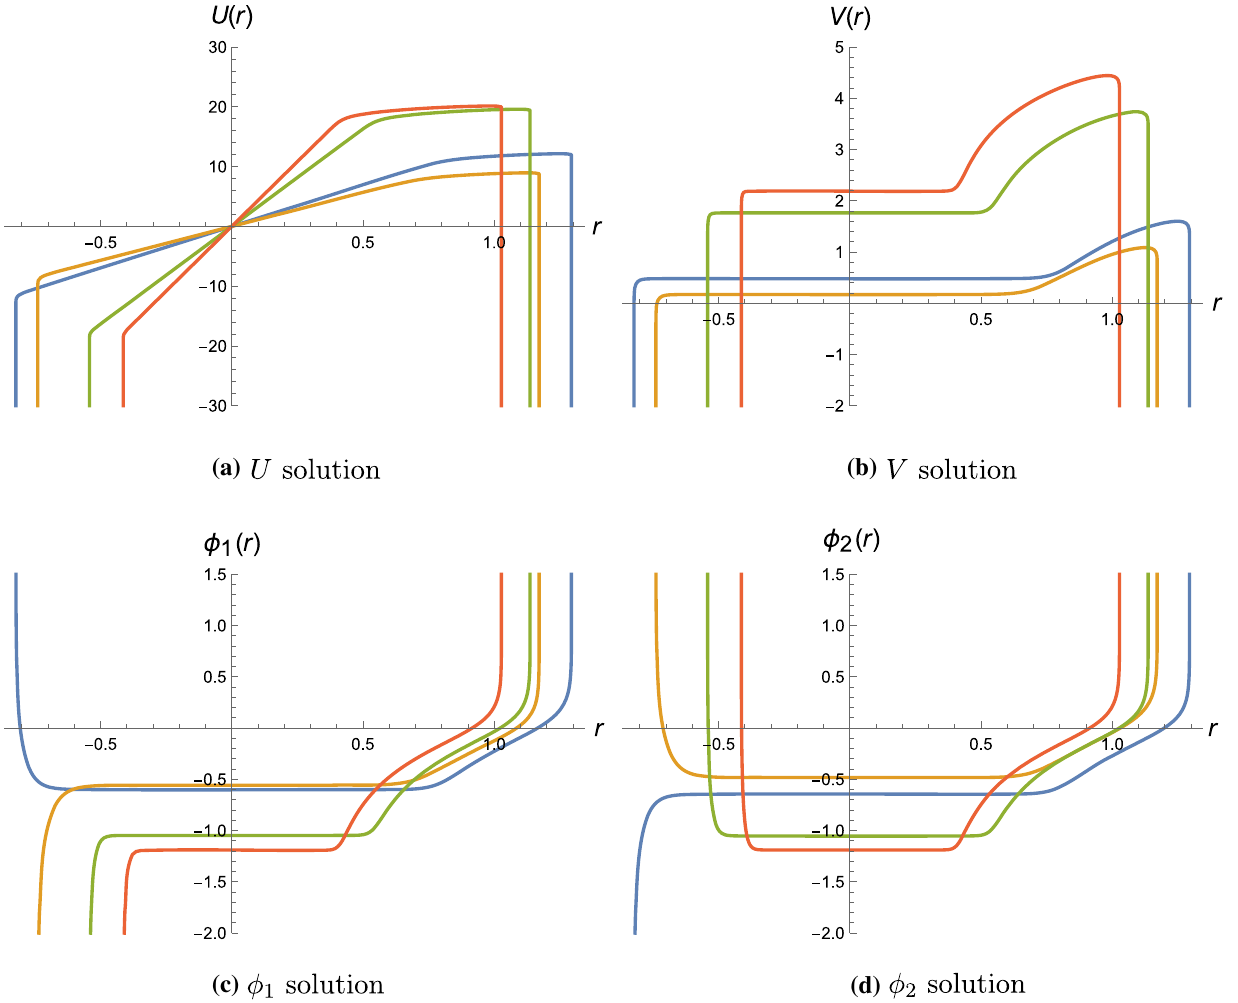
Fig. 27 RG flows between AdS 3 × CP 2 fixed points and curved domain walls for SO ( 2 ) × SO ( 2 ) twist in SO ( 4 , 1 ) gauge group. The blue, orange, green and red curves refer to p 2 = 1